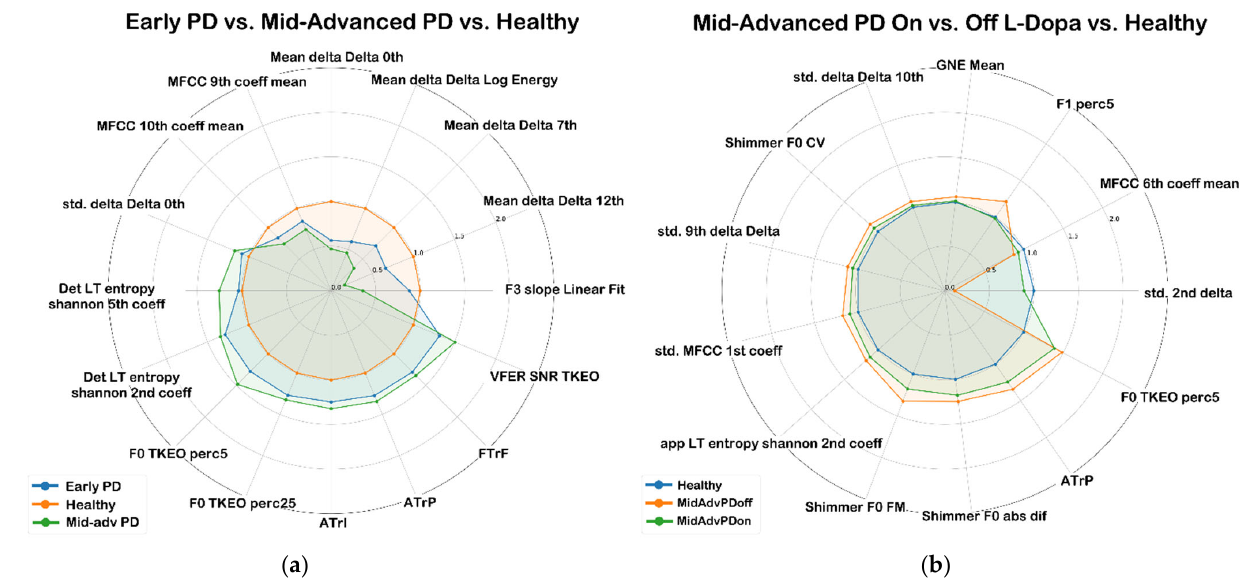
Figure 7. Spider plots of some of the most significant features for different comparison scenarios:( a ) most significant features in differentiating between early or mid ‐ advanced PD ( a ) most significant features in differentiating between early or mid-advanced PD subjects and subjects and HCs; ( b ) most significant features in differentiating between ON and OFF L ‐ Dopa HCs; ( b ) most significant features in differentiating between ON and OFF L-Dopa mid-advanced mid ‐ advanced PD subjects. PD